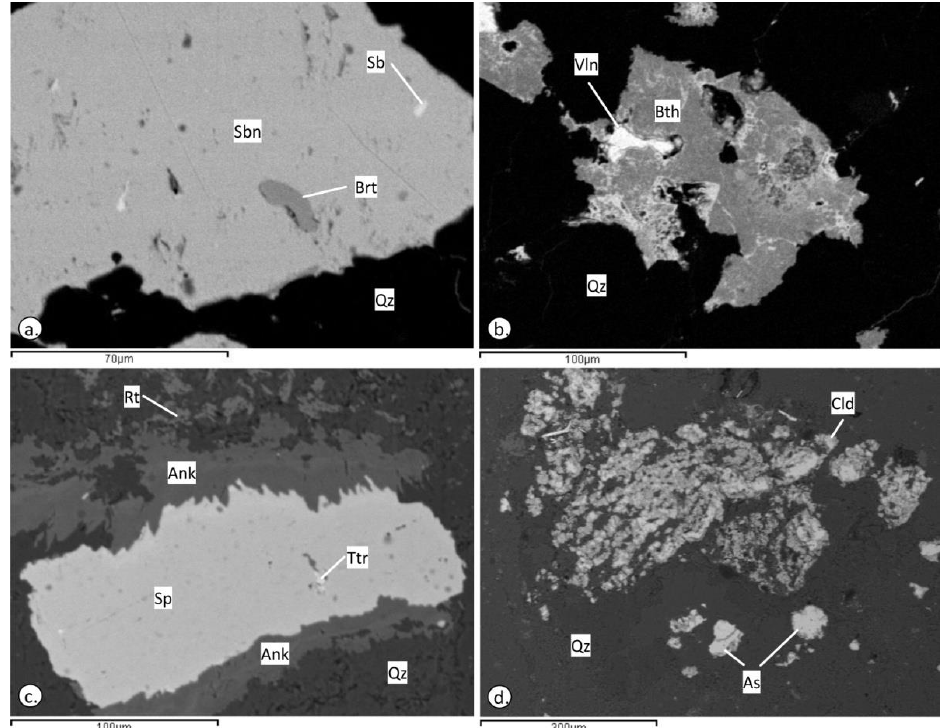
Figure 10. SEM back-scattered electron images of the stibnite mineralization: ( a ) Stibnite (Sbn) bearing barite (Brt) and native antimony (Sb) in quartz (Qz); ( b ) Berthierite (Bth) fills a cavity in quartz (Qz) and is oxidized to valentinite (Vln); ( c ) Sphalerite (Sp) is rimmed by ankerite (Ank) and includes tetrahedrite (Ttr). The ground mass includes quartz (Qz) and rutile (Rt); ( d ) Claudetite (Cld) and native arsenic (As) fill cavities in quartz (Qz).